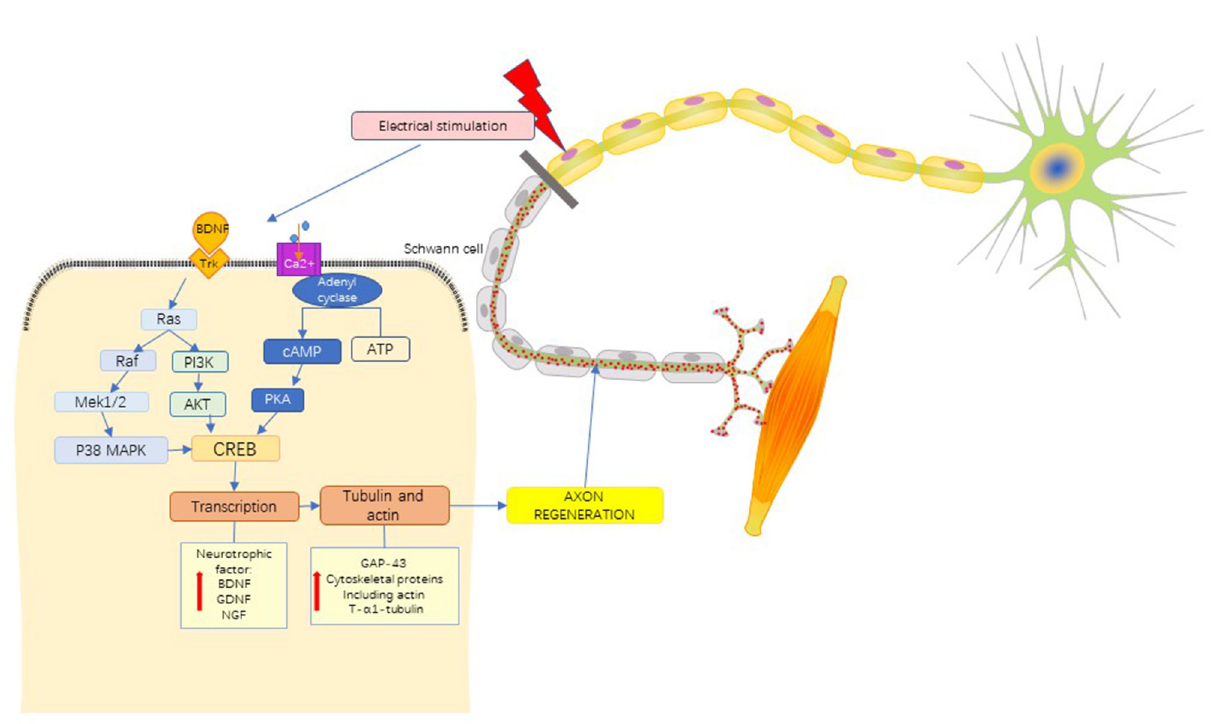
FIGURE6 Mechanistic pathways of ES in the treatment of PNI. brain-derived neurotrophic factor, BDNF; Tyrosine kinase receptor, Trk; mitogen-activated proteinkinase kinase 1/2, MEK 1/2; P38 mitogen activated protein kinase, P38 MAPK; phosphoinositide 3-Kinase, PI3K; protein Kinase B, PKB(AKT); adenosine triphosphate, ATP; cyclic adenosine monophosphate, cAMP; protein kinase A, PKA; cAMP-response element binding protein, CREB; glial cell line-derived neurotrophic factor, GDNF; nerve growth factor, NGF; growth associated protein-43, GAP-43. See the text in the section “4.1.4 Mechanism” for a detailed